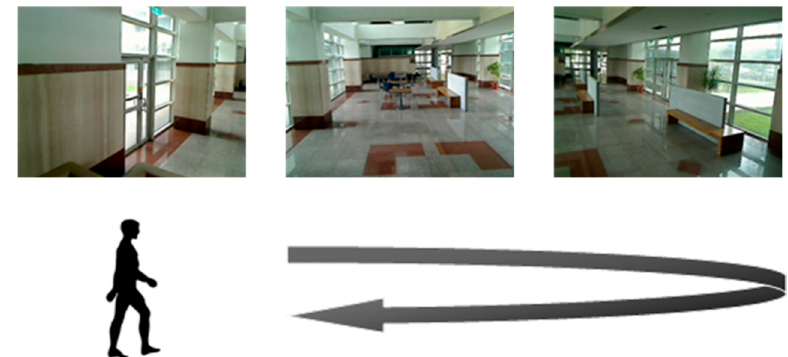
Figure 10. Three cameras view for one person tracking.